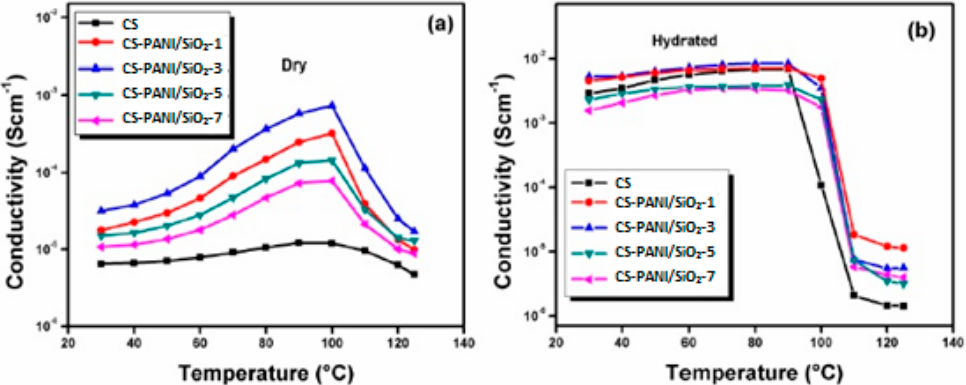
Figure 4. Proton conductivity of ( a ) dry and ( b ) hydrated CS-polyaniline / nanosilica (PANI / SiO 2 ) hybrid membranes with increasing temperatures [26]. Copyright 2018, reproduced with permission from Elsevier